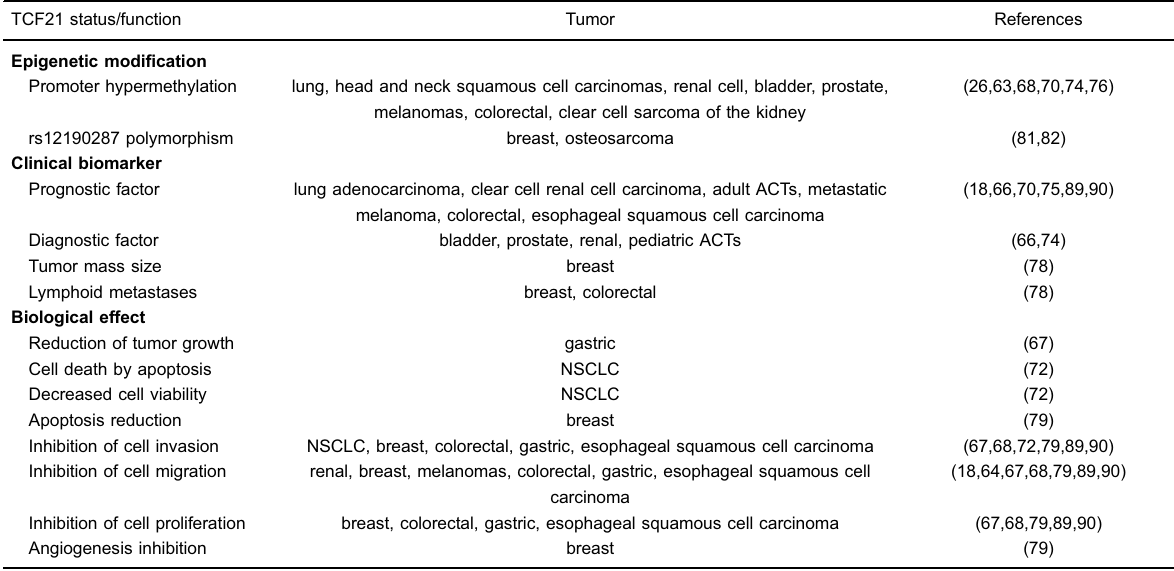
Table 2. Transcription factor 21 (TCF21) in